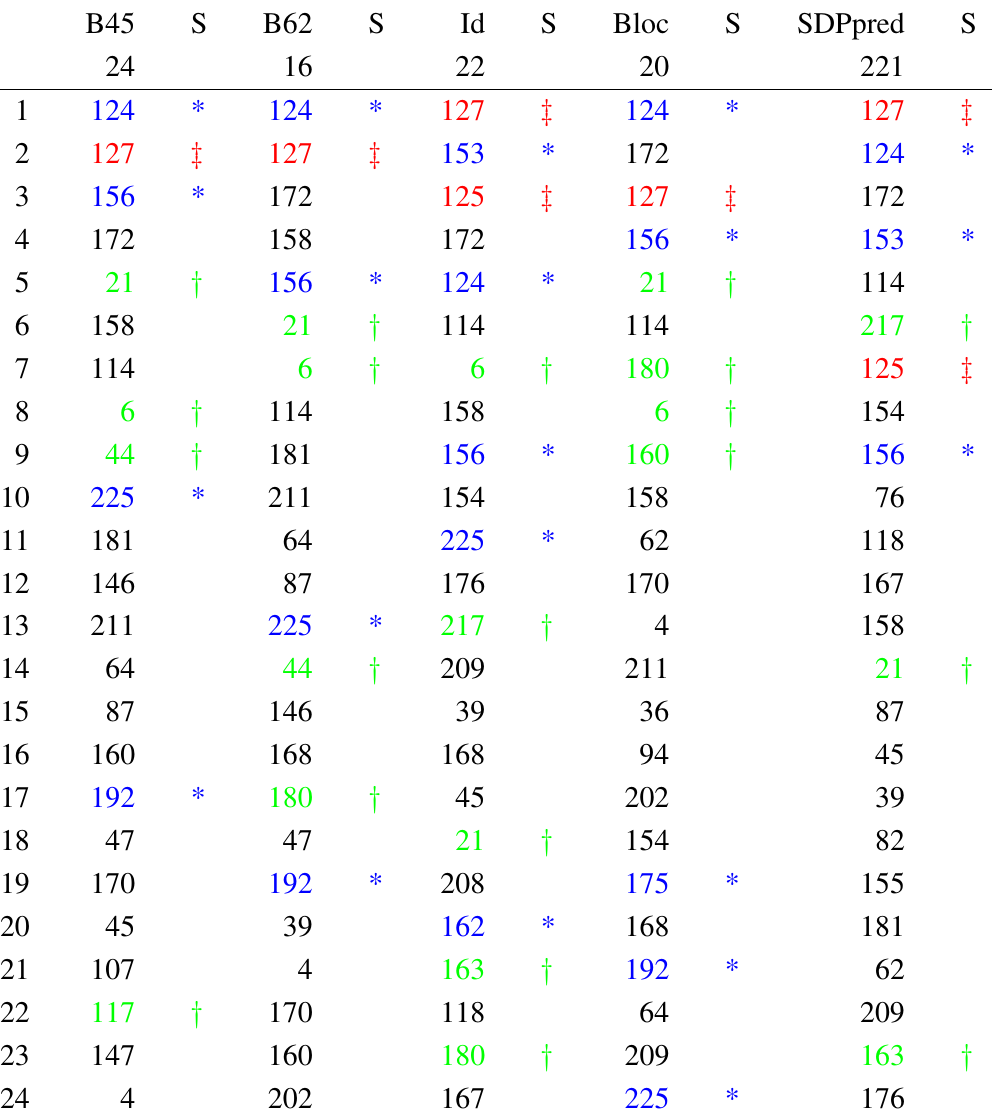
Table 7. SDPs inferred from 66 Di- and Tetrameric DsRed homologs. The Table shows the 24 best ranking SDPs. Scores discriminate experimentally validated positions( ∗ ) from those responsible for generic multimerization( † ) and those beneficial or even specific to the dimer- to-tetramer step( ‡ ), according to [27]. Positions with different scores are colored differently to facilitate